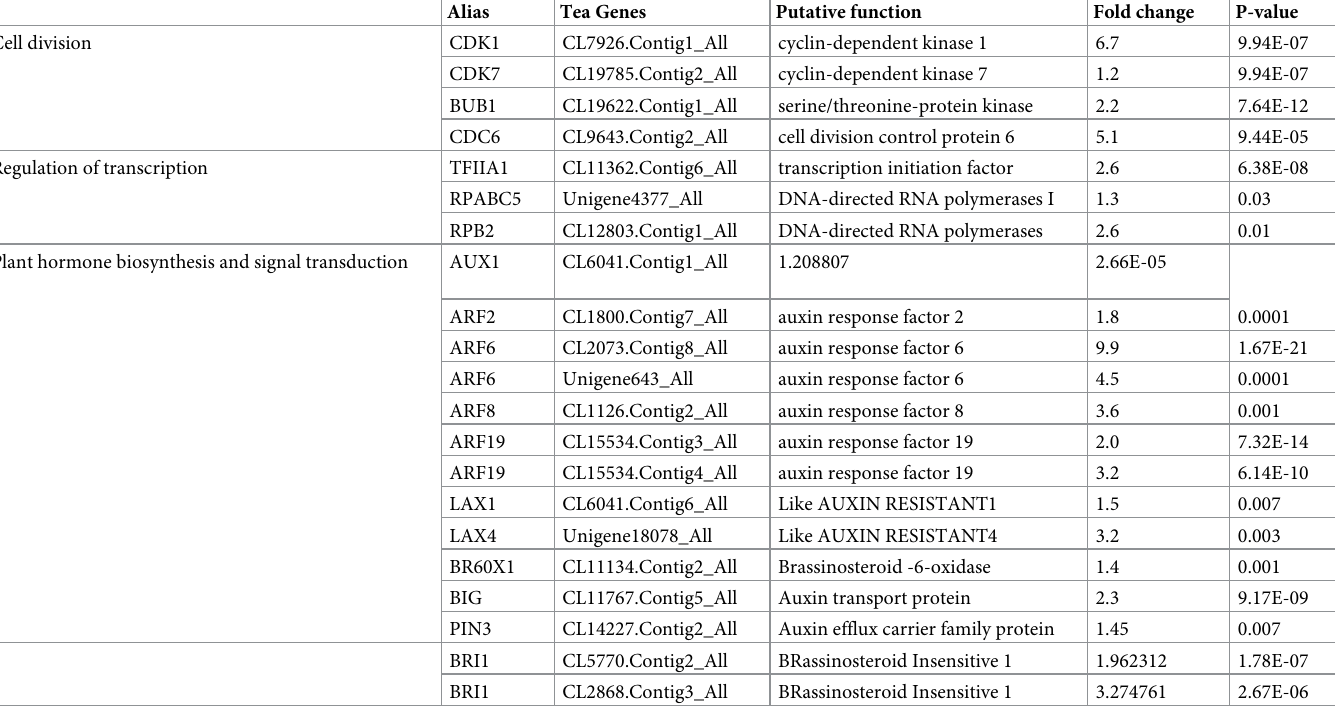
Table 3. Differentially expressed genes involved in leaf developmental growth in diploid and